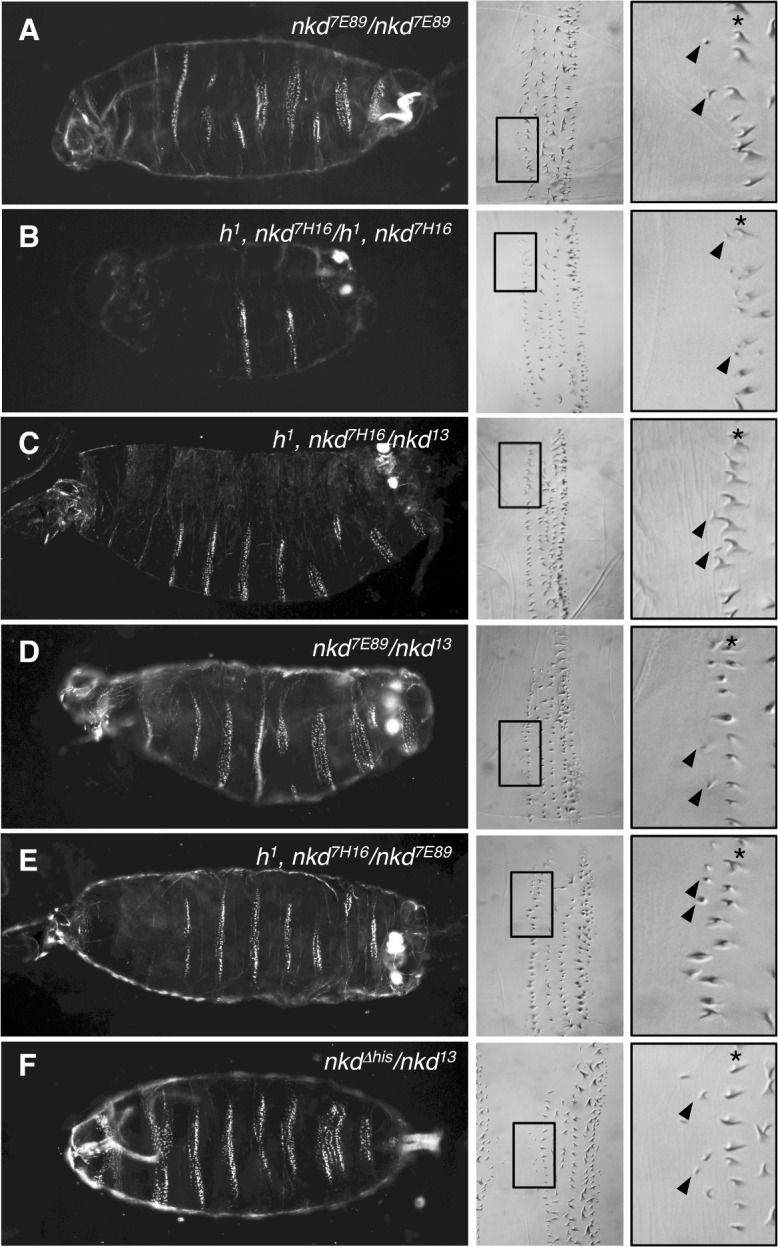
Excess anterior denticles in transheterozygous embryos bearing different combinations of nkd alleles.Images of ventral cuticles of embryos bearing different combinations of nkd and h1 alleles as indicated in panels, exhibiting excess anterior denticles. Left, dark-field; right, DIC.